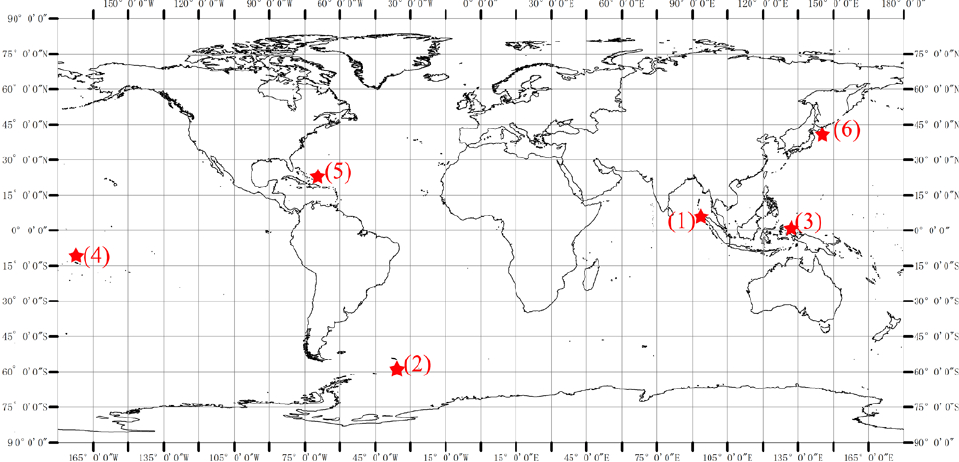
Fig. 1. Locations of studied